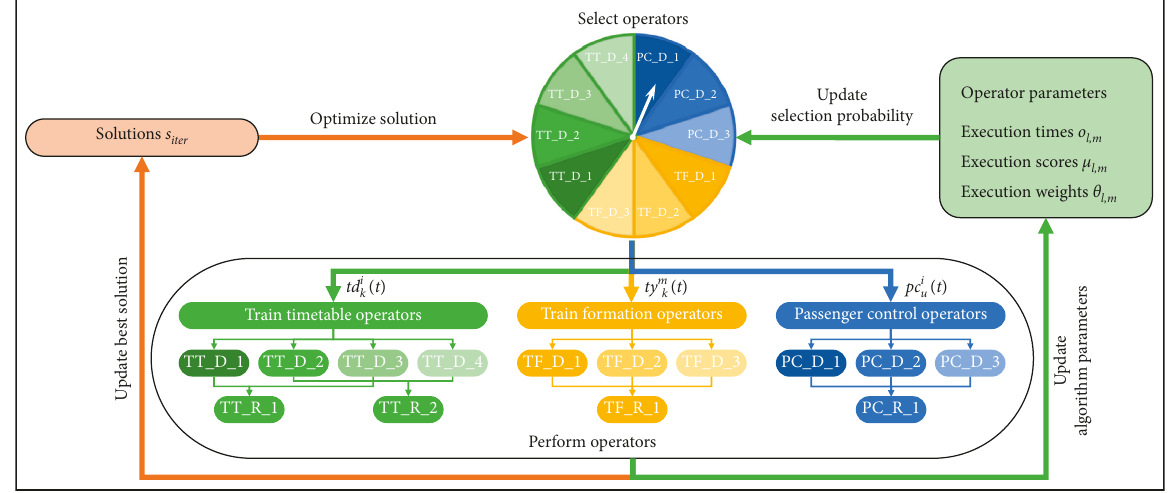
Figure 3: The selection and update process of execution